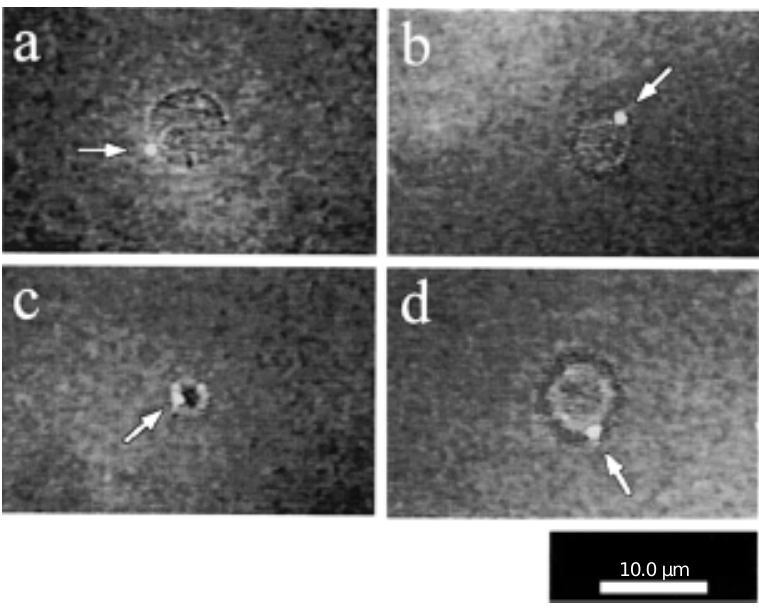
Figure 7. Light microscopy images of single T4 DNA globules adsorbed onto the surface of positively charged catanionic vesicles. Arrows indicate single DNA globules. Reprinted from Ref. 38, with